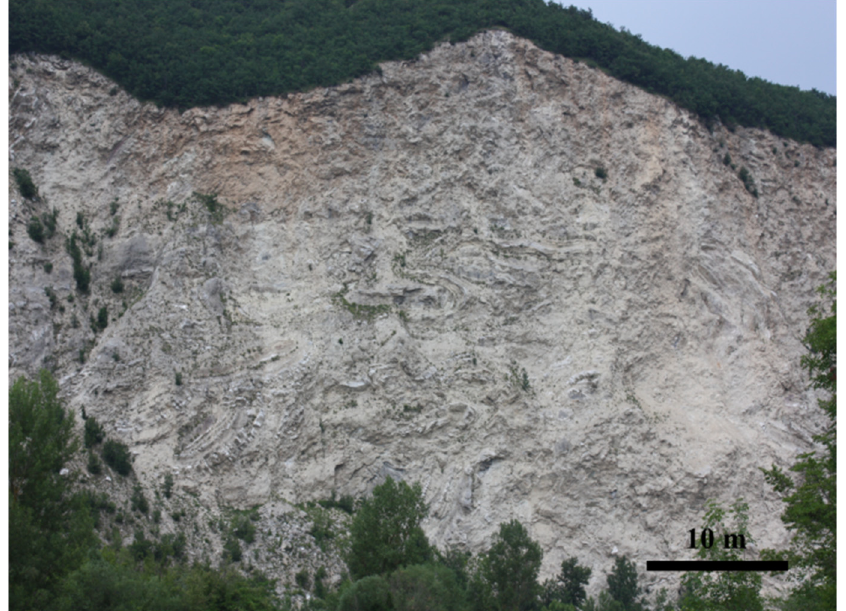
Figure 3. Southern slope of Mt. Rosso outcropping along River Secchia Valley, with widespread phenomena of